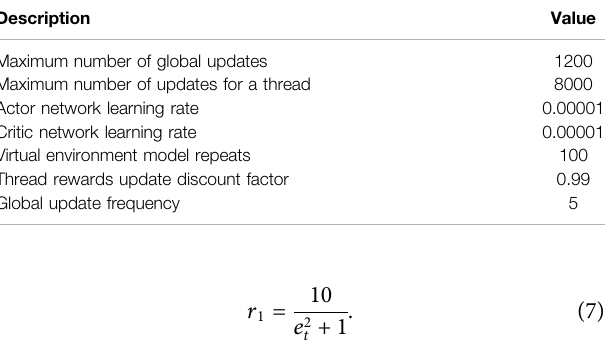
FIGURE 3 | Input and output variables of the boiler combustion system.